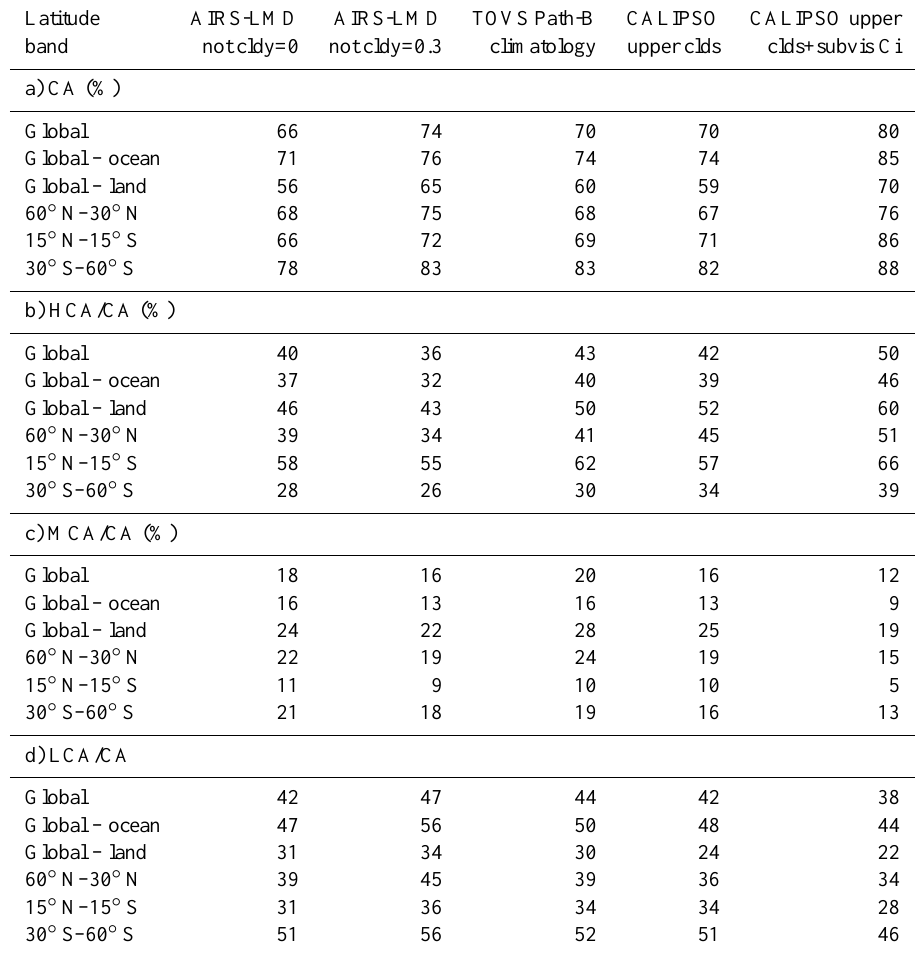
Table 2. Cloud amount from the AIRS-LMD cloud climatology, determined as the fraction of cloudy AIRS spots (not cloudy spots have a weight of 0). Results are also shown when in the computation not cloudy AIRS footprints are added with a weight of 0.3 (meaning that not cloudy footprints have on average 30% cloud). For further comparison are shown results from the TOVS Path-B cloud climatology (1987–1995), and results using CALIPSO considering only uppermost layers, once excluding subvisible cirrus and once including them. Averages are shown over the globe, separately over ocean and over land, and over NH midlatitudes (30 ◦ N–60 ◦ N), tropics (15 ◦ S–15 ◦ N) and SH midlatitudes (30 ◦ S–60 ◦ S): a) total (CA), b) high, c) midlevel and d) lowlevel.